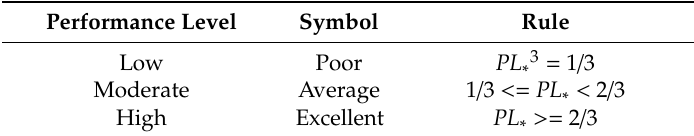
Table 7. Rules for symbolic performance